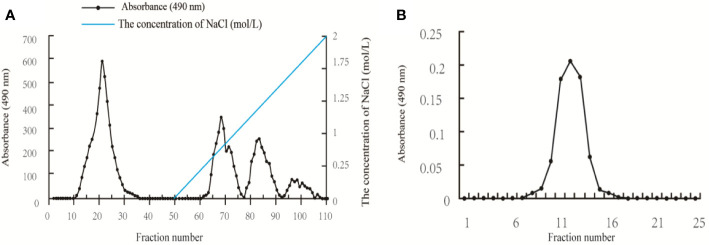
Elution profiles of the polysaccharides isolated from Auricularia auricular: (A) Elution profile of the A. auricula polysaccharides (AAP) on DEAE-52 column; and (B) Elution profile of AAP1 on Sephacryl S-400 column.